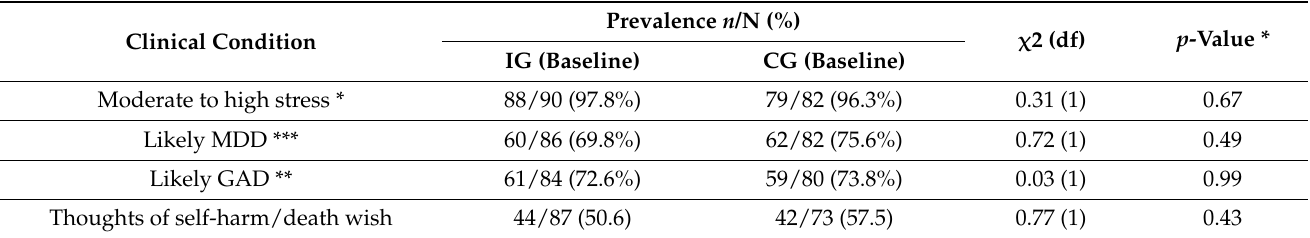
Table 5. Chi-square association test comparing the baseline prevalence of clinically meaningful problems in the IG and